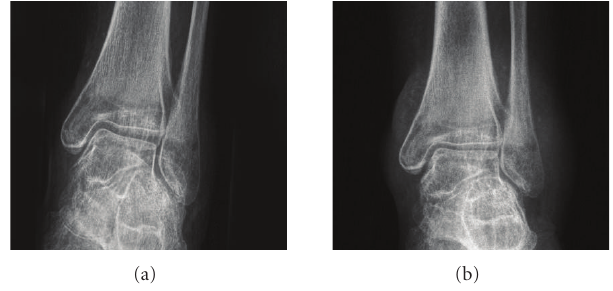
Figure 5: (a) An anterior-posterior radiograph showing the ankle without relevant signs of arthrosis 1 years postoperatively. Osteope- nia due to the limited exposure of the leg. (b) An anterior-posterior and lateral radiograph showing the ankle 15 years postoperatively without relevant signs of